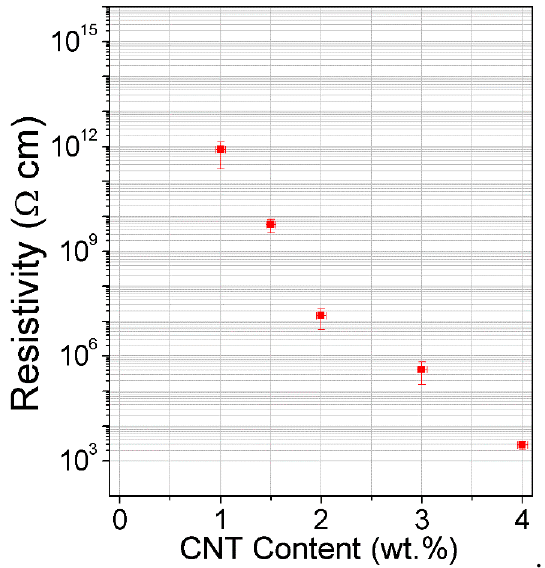
Figure 3. Electrical resistivity of MWCNT/PP as a function of the filler wt. percentage.